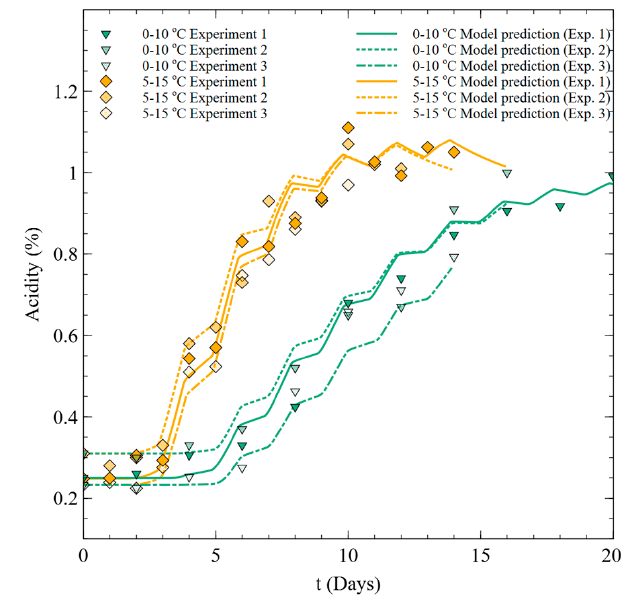
Figure 6. Comparison of measured acidity variation and predictions of the model with the assumption of N max = N max ( T ) for experiments 1–3.